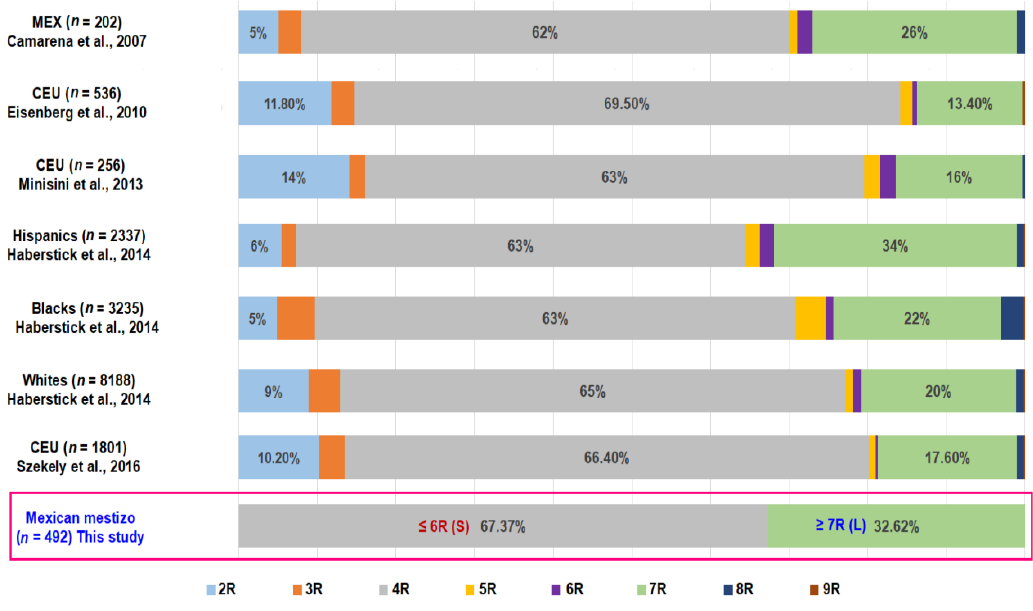
Figure 2. Allele frequencies of VNTR in DRD4 in seven human populations and in the current study.